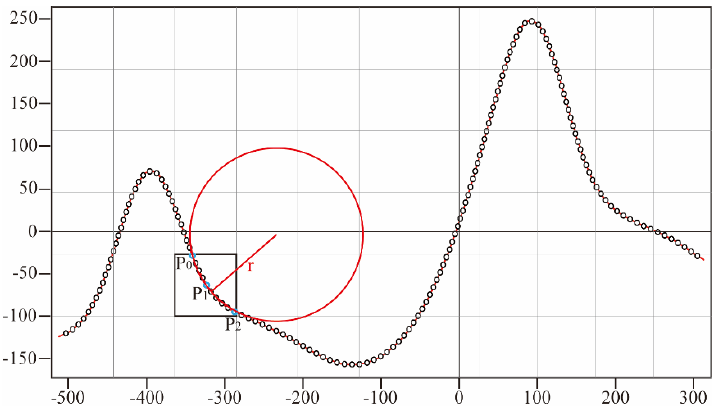
Figure 5. Fitting the circle of the grid cell by the least square algorithm.